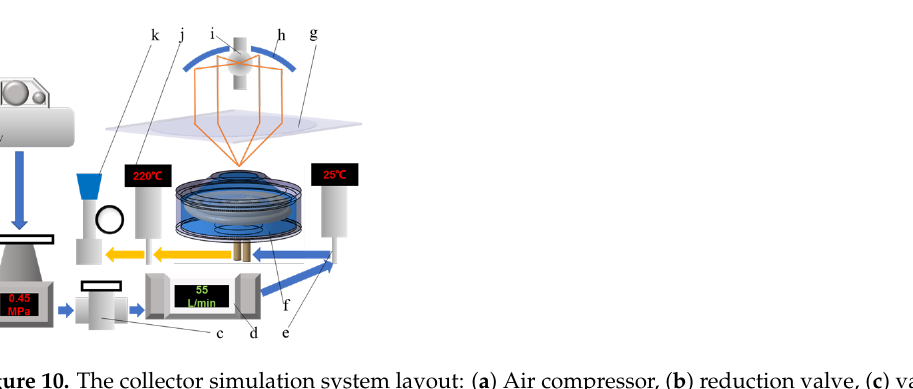
Figure 10. The collector simulation system layout: ( a ) Air compressor, ( b ) reduction valve, ( c ) valve, ( d ) volumetric flow meter, ( e ) temperature transmitter, ( f ) cavity receiver ( g ) Fresnel lens, ( h ) parabolic reflector, ( i ) Xenon lamp, ( j ) temperature transmitter, ( k ) back-pressure valve. The setup of the experiment system is shown in Figure 11.